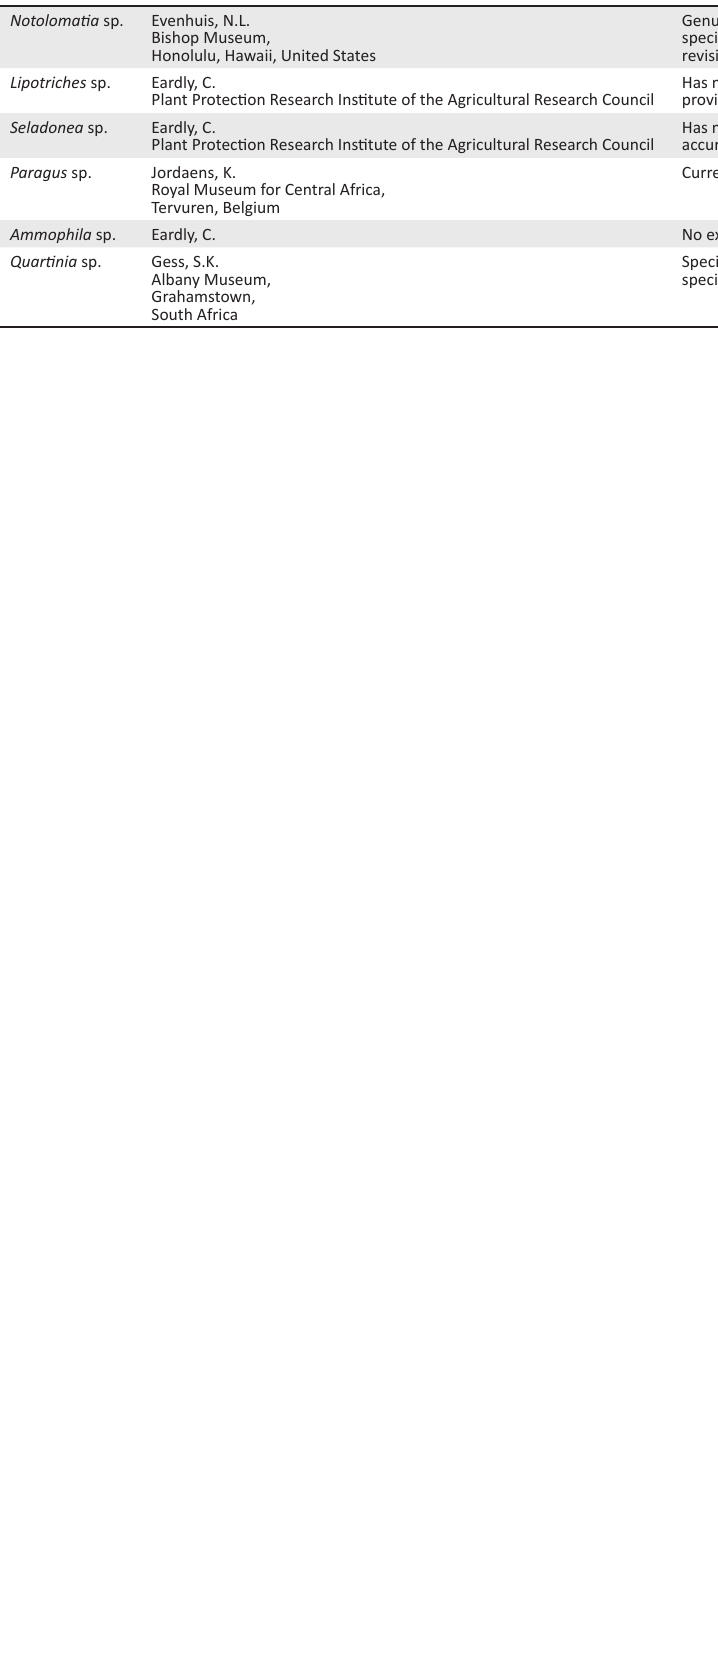
TABLE 1-A1: Specialist identifications of Frithia humilis pollen carriers not considered in Harris et al. (2016). Family